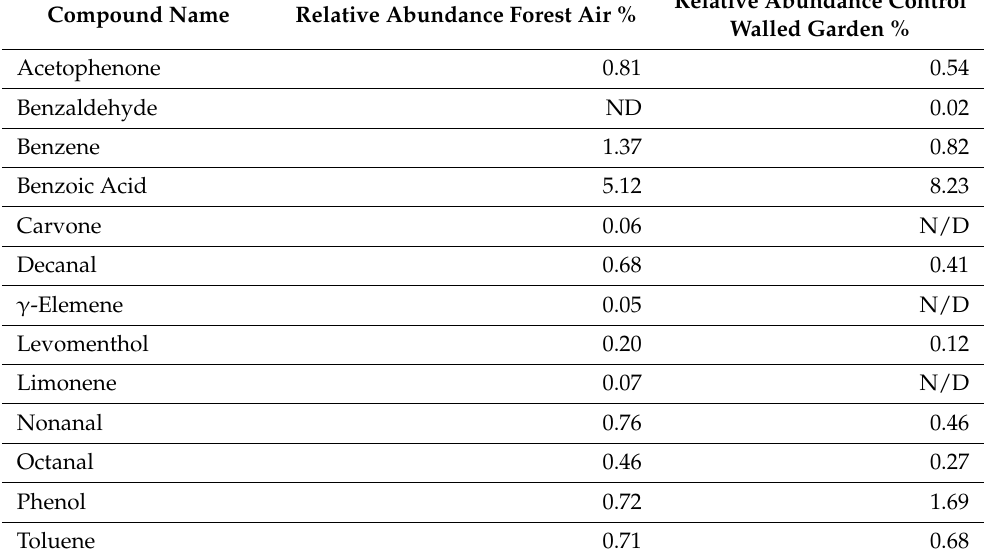
Table 2. List of the most common NVOCs found in the forest air samples. N/D denotes compound not